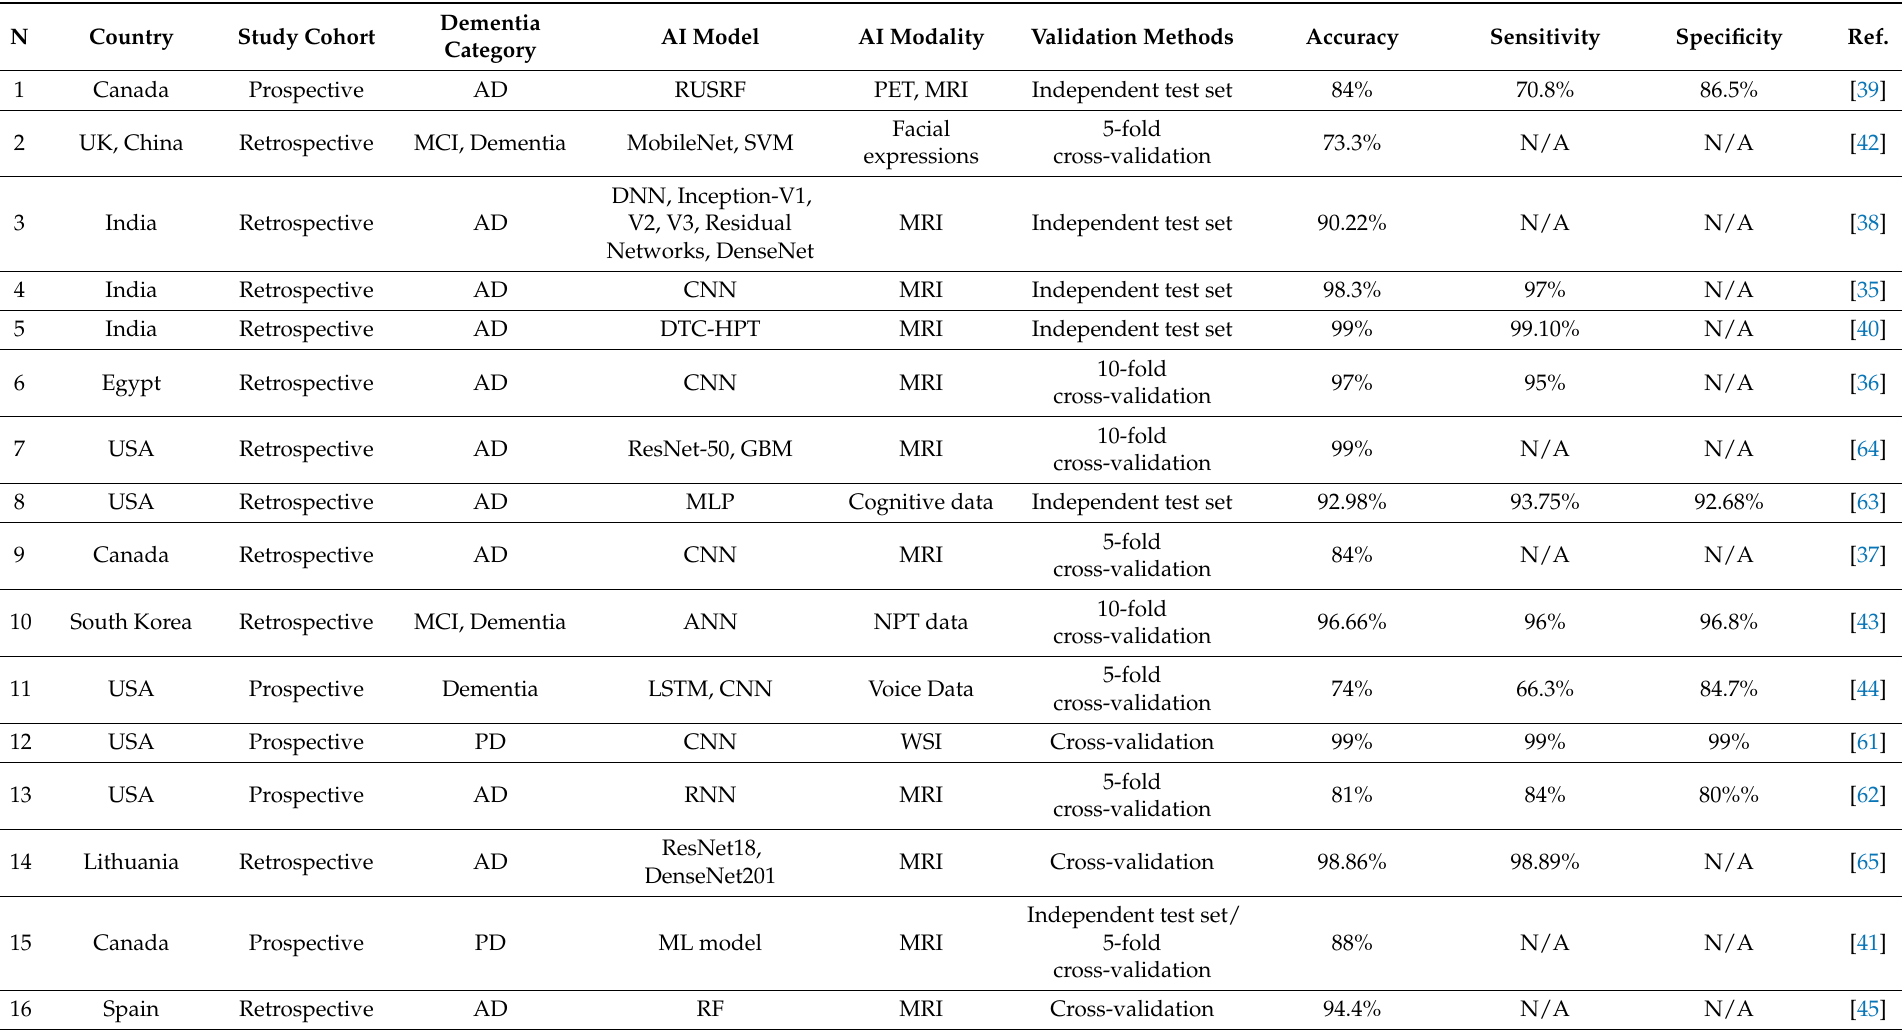
Table 2. Characteristics of papers included in the